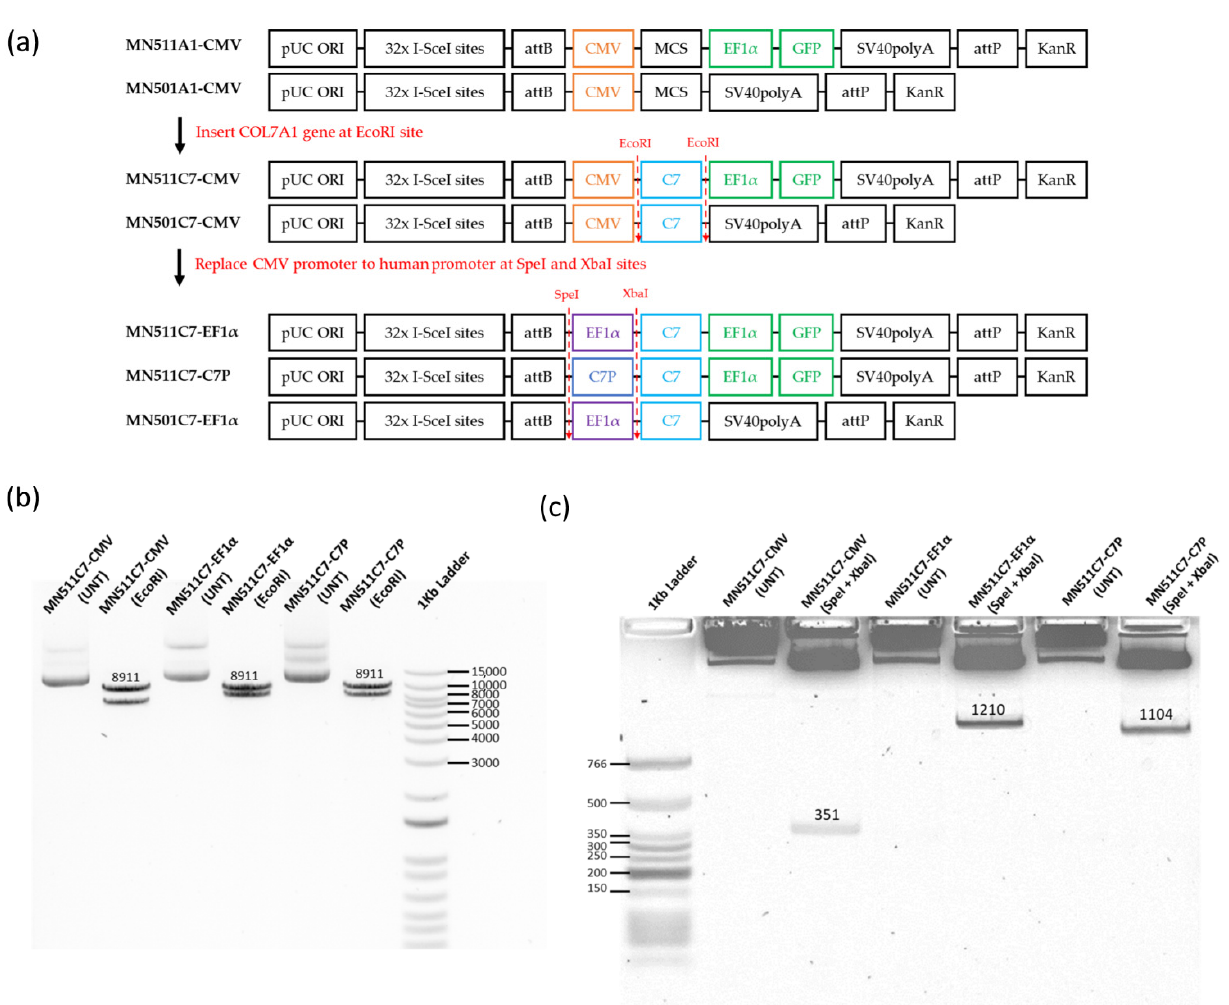
Figure 1. MN511C7 parental plasmid construct confirmation. ( a ) Scheme of type VII collagen (C7) minicircle parental plasmid construction. ( b ) MN511C7- control viral cytomegalovirus (CMV) plasmid (MN511C7-CMV), MN511C7- eukaryotic translation elongation factor 1 α (EF1 α ) plasmid (MN511C7- EF1 α ), and MN511C7-COL7A1 tissue specific promoter (C7P) plasmid (MN511C7-C7P) were digested by EcoRI restriction enzyme digestion, and the digested products were separated on a 0.8% agarose gel. All the plasmids had an 8911 kb C7 band. ( c ) MN511C7-CMV, MN511C7-EF1 α , and MN511C7-C7P were digested by SpeI and XbaI dual restriction enzyme digestion. CMV (351 bp), EF1 α (1210 bp) and C7P (1104 bp) bands on a 0.8% agarose gel confirmed the successful promoter replacements.